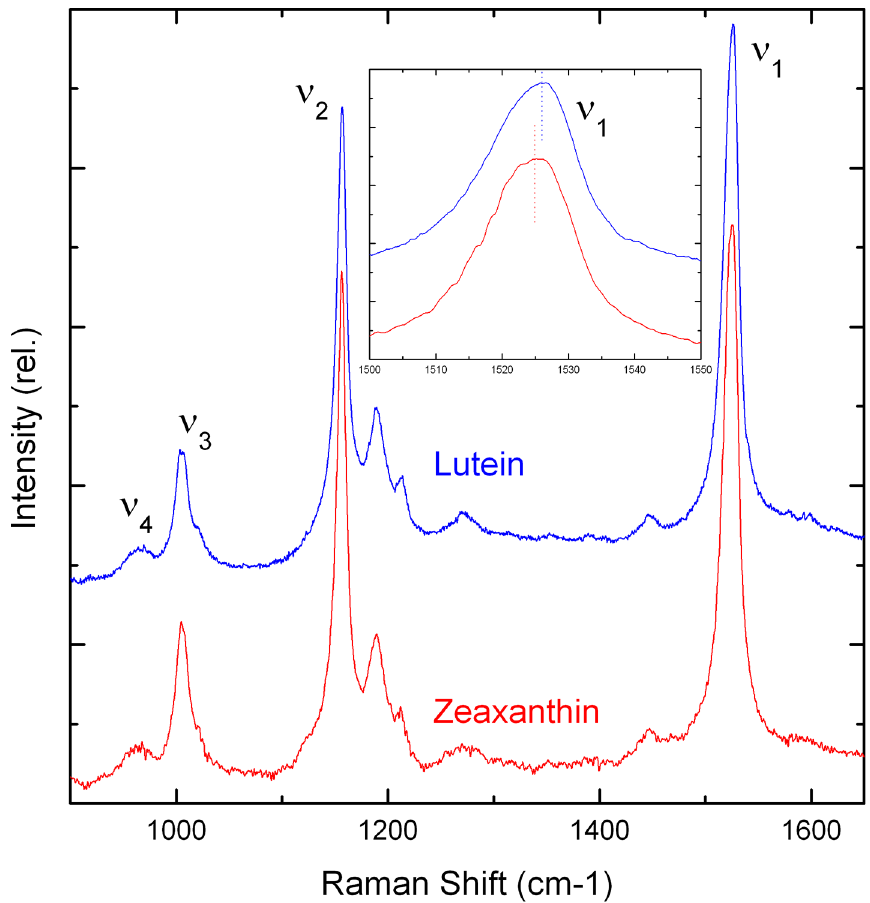
Fig 2. Resonance Raman spectra of MP carotenoids in vitro . Room temperature spectra in the 900 – 1650 cm -1 region are shown for zeaxanthin (red) and lutein (blue) in THF, excited at 488.0 nm. Inset: detail of the ν 1